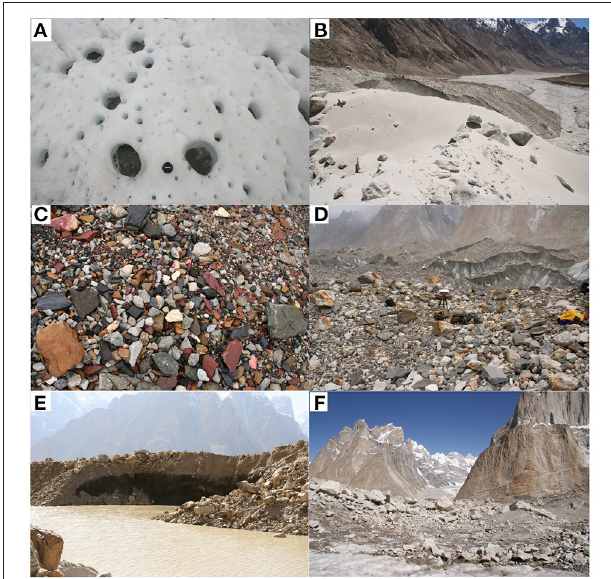
FIGURE 3 | Supraglacial debris cover conditions on the Baltoro Glacier during the summer of 2005. The nature of the supraglacial debris load can vary significantly with respect to particle size, composition, and debris thicknesses. (A) Cryoconite holes at Concordia at 4,500 m. These features form as wind blown dust, soot and particles that absorb radiation generate holes that contain water that contributes further to increase ablation and the depth and width of the hole. (B) Wind blown silt and sand deposits at the terminus of the glacier. Wind turbulence caused by up valley winds and altitude variations between the pro-glacial valley floor and the glacier surface results in wind-sorted supraglacial debris. (C) Supraglacial debris load consisting of gravel, pebbles, and cobble-sized particles. Notice the felsic and mafic compositional variations of particles. (D) Supraglacial debris dominated by larger rocks over the glacier surface. Rock spatial density greatly governs the spatial variation in ablation dues to shadowing and rock mass influence on the vertical debris load thermal gradient. (E) Debris load consisting of sediment, rocks, and boulders. Debris thickness is about 5 m. Debris thickness can be highly variable over a glacier surface depending upon a multitude of controlling factors. (F) Debris loads in the Himalaya frequently consist of boulder fields, that make it difficult to accurately assess or model thermal gradients, given shadowing and alternation of the wind field. Photo credit: Michael P.